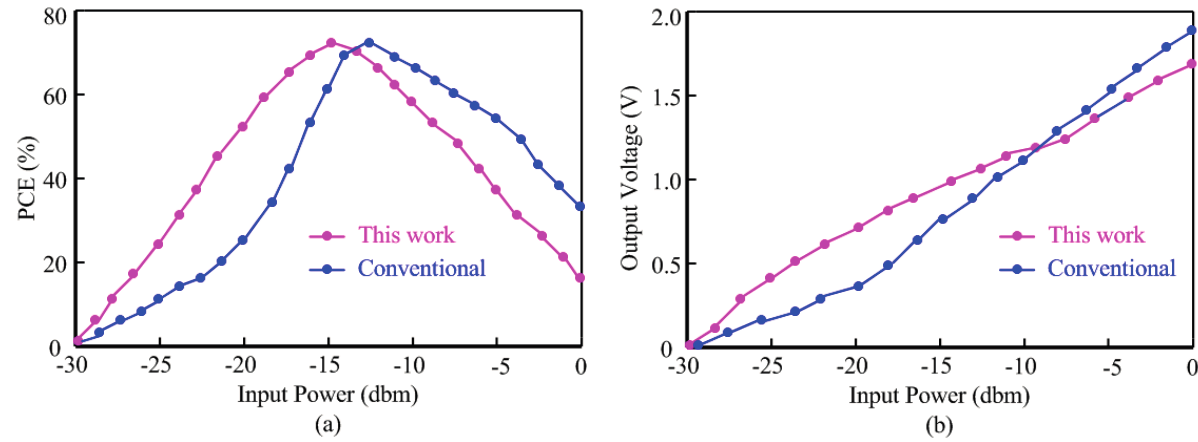
Figure 11. Performance comparisons between conventional architecture and this work; ( a ) PCE comparison; ( b ) output voltage